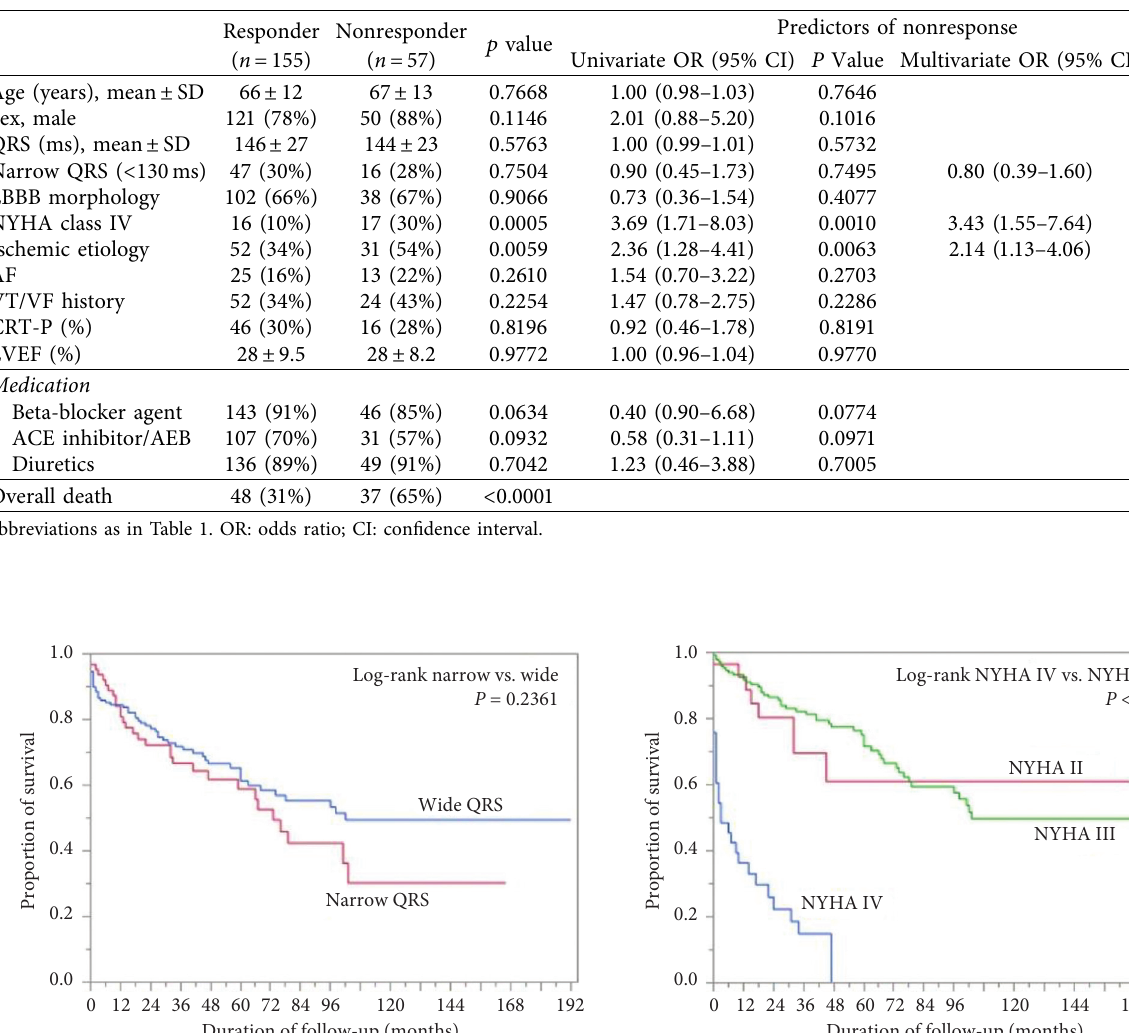
Table 3: Patient characteristics: responders versus nonresponders and predictors of nonresponse to CRT.